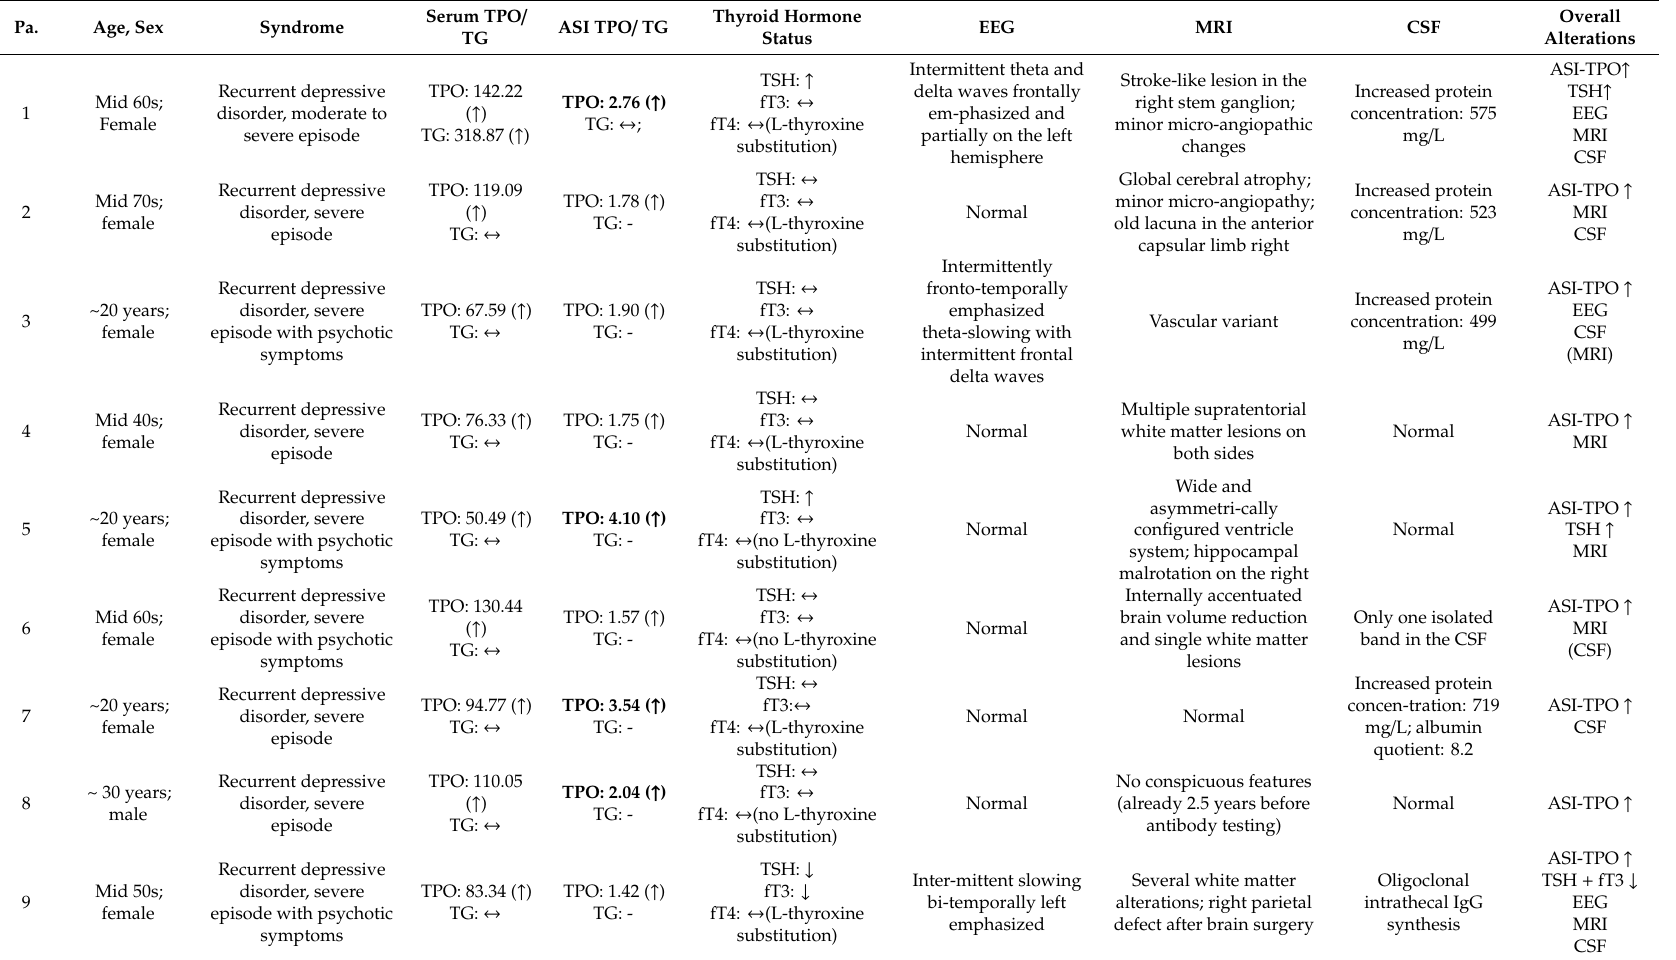
Table 2. Patients with depression and increased antibody specific indices